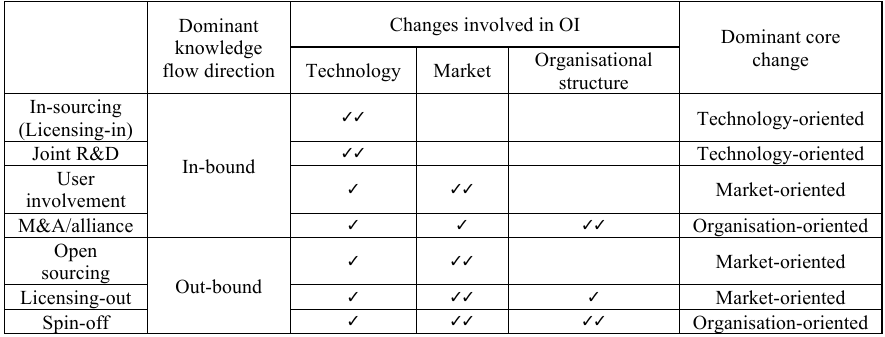
Table 1. Open innovation classification (Note: ‘ ✓ ’denotes a low and‘ ✓✓ ’ denotes a high level